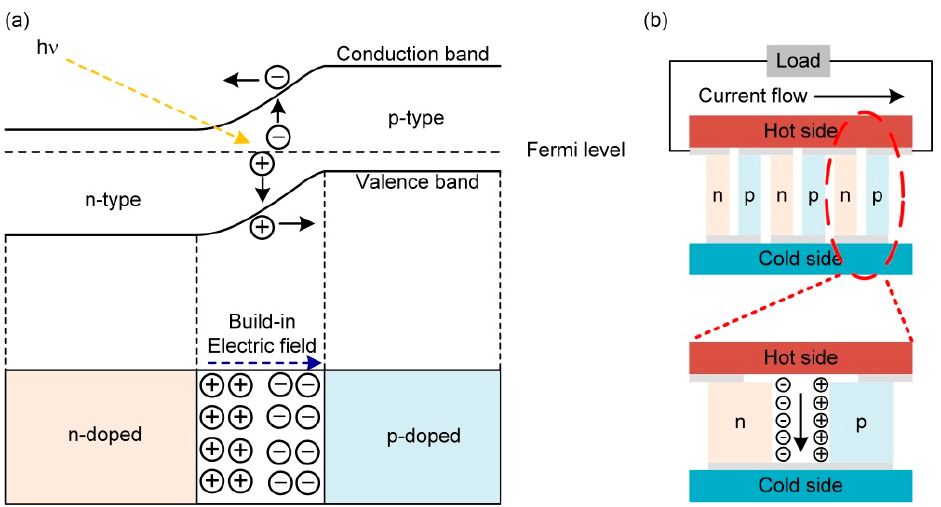
Figure 2. Schematic diagrams of ( a ) photovoltaic effect and ( b ) a TE module ( top ) and a TE element ( bottom ).